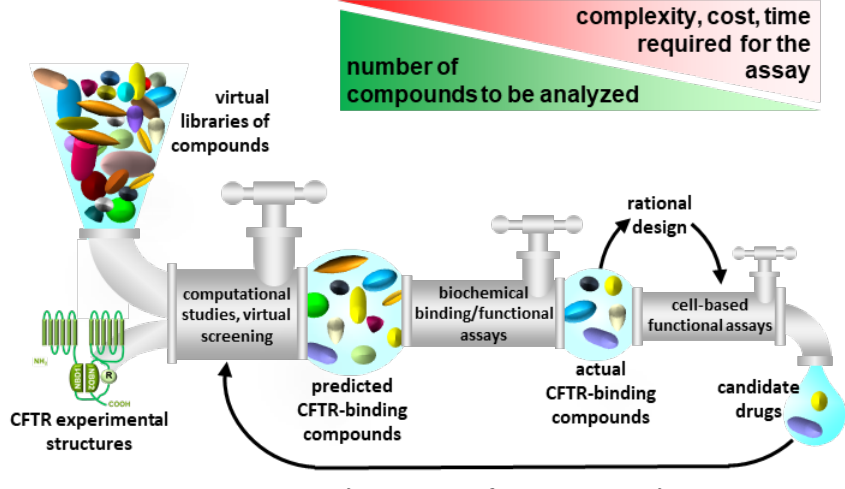
Figure 8. Integration of computational, biochemical and cell-based models in the pipeline for CF drug discovery. In the pipeline proposed, the number of compounds to be analyzed progressively decreases with the increasing of the complexity and costs of the analyses employed. The study of the chemical features of the hits may help the rational modification or de novo design of candidate drugs with improved binding affinity/rescuing capability. On the other hand, in deep computational docking and/or MDs of hits may help the comprehension of their CFTR-rescuing mechanisms.